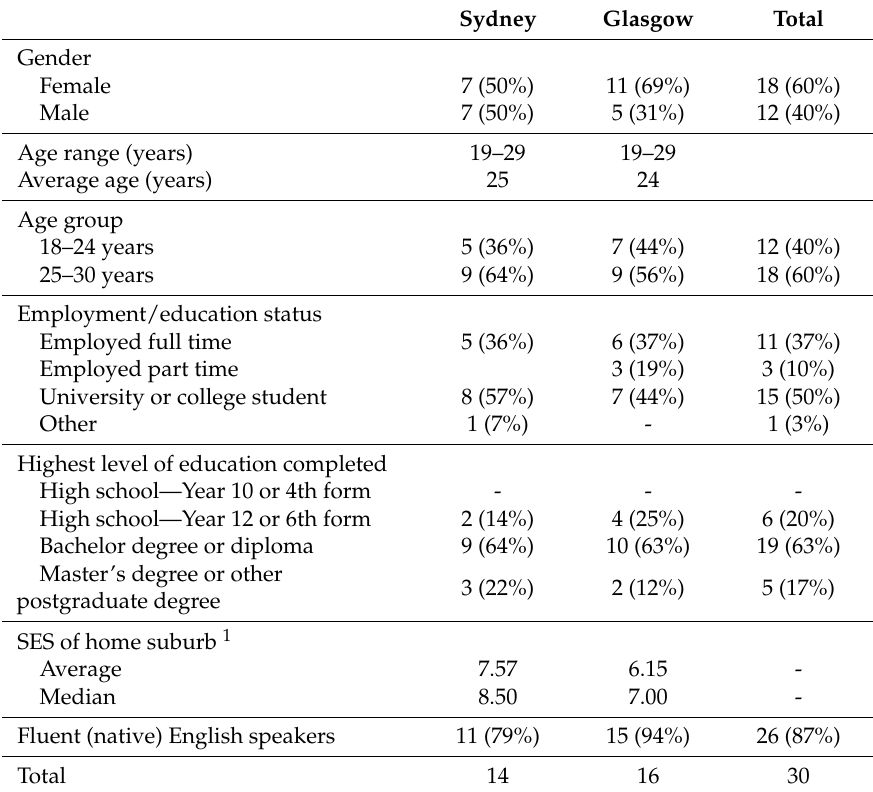
Table 1. Characteristics of focus group